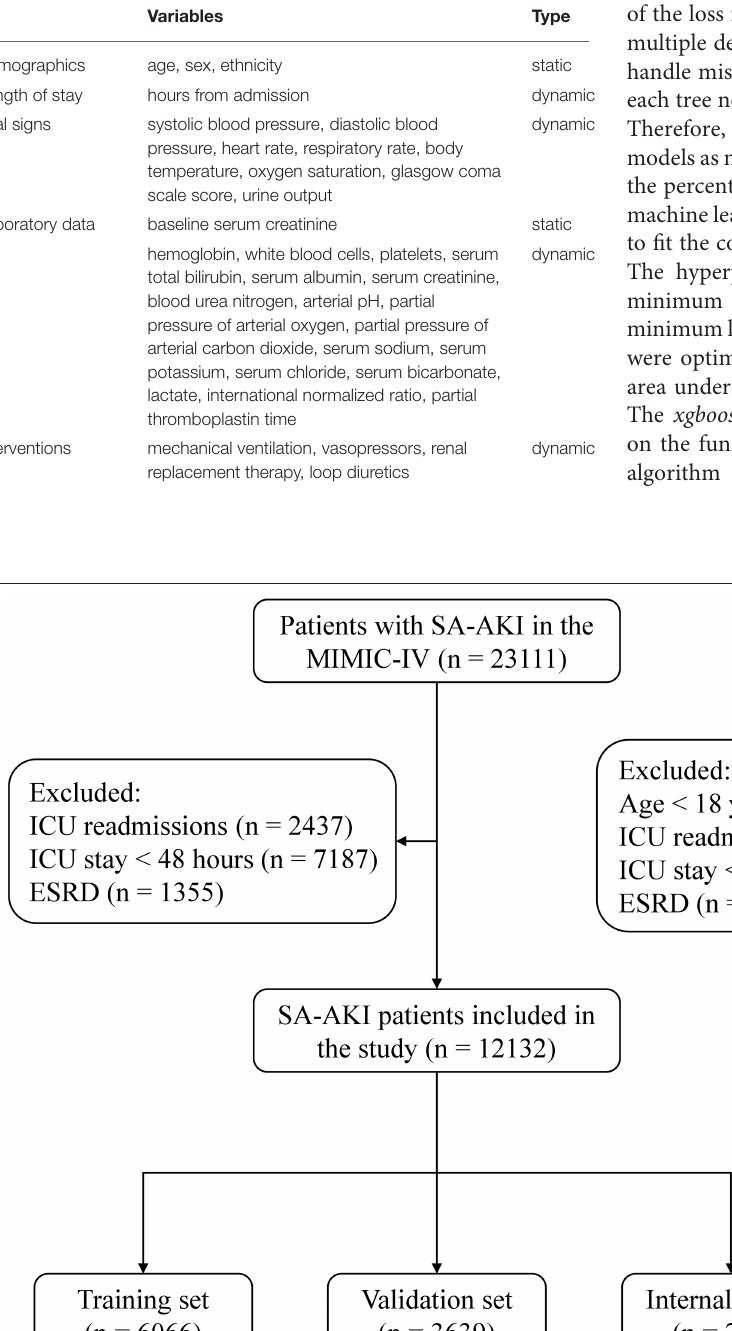
TABLE 1 | List of the predictor variables.